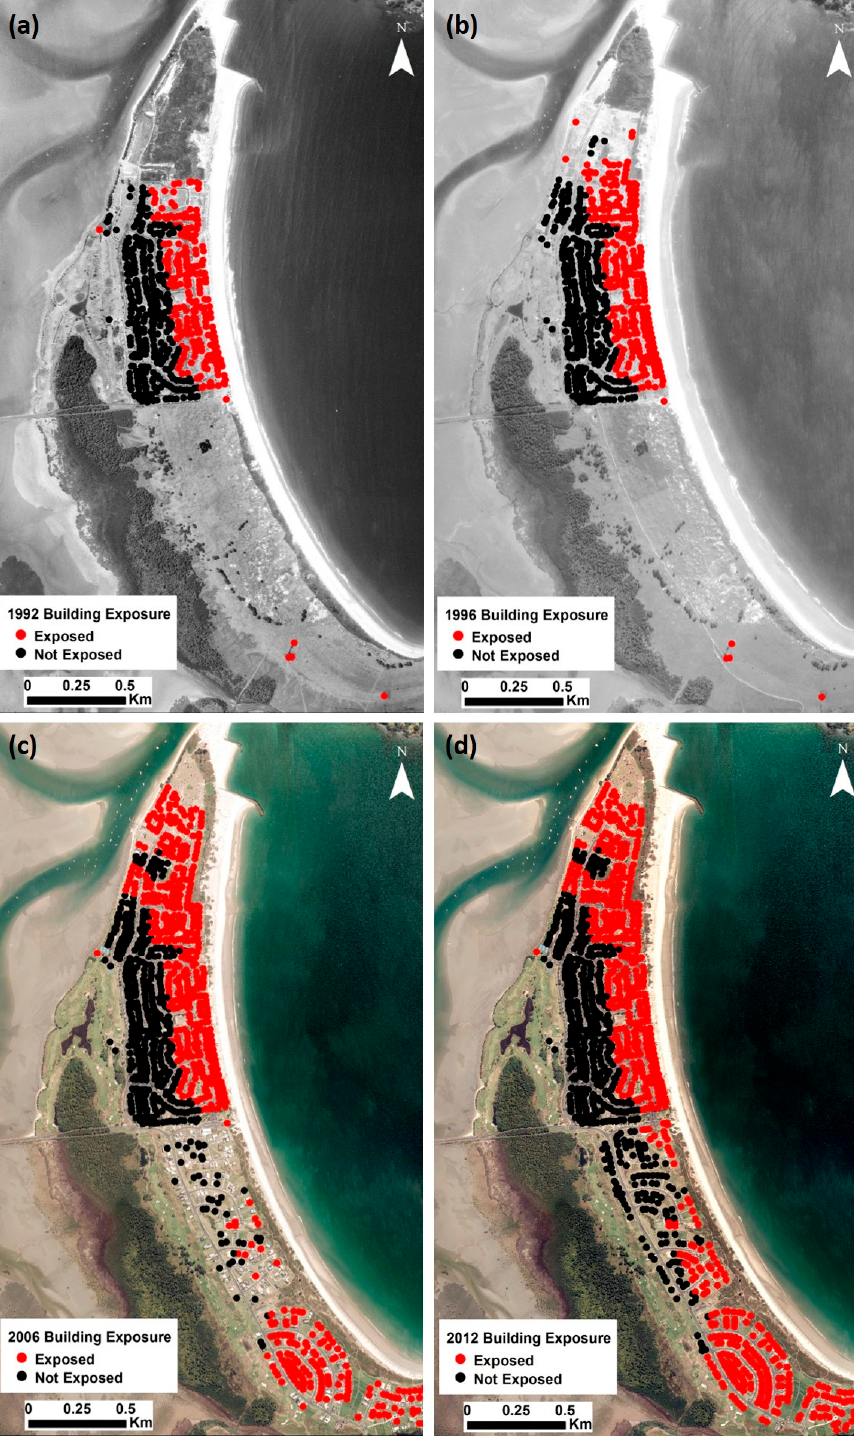
Figure 4. Urban settlement development in Omaha Beach in ( a ) 1992, ( b ) 1996, ( c ) 2006 and ( d ) 2012. Buildings exposed to modelled maximum regional source tsunami inundation are identified (red).